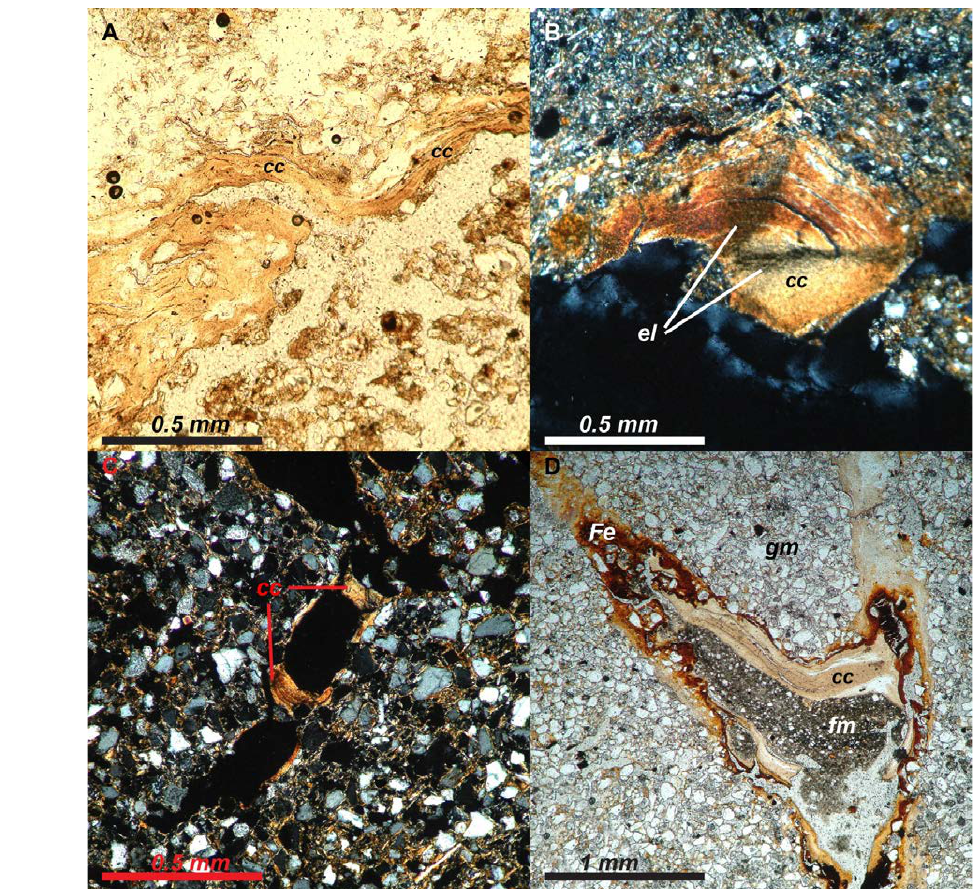
Figure 6. Thin sections of (A) clay coatings in profile e at a depth of 70 cm (PR0), PPL. (B) Layered clay with extinction lines in profile e at a depth of 130cm (PR0), XPL. (C) One of the few clay accumulations found in PR1 (profile j, depth of 100 cm), XPL. (D) Root canal with iron hypocoating, clay coating and dense incomplete infilling of finer material in profile h, depth of 80cm (PR1), PPL. cc: clay coatings, el: extinction lines, ab: air bubbles in the mounting medium, gm: greyish matrix, Fe: iron hypo-coating, fm: fine-grained matrix.